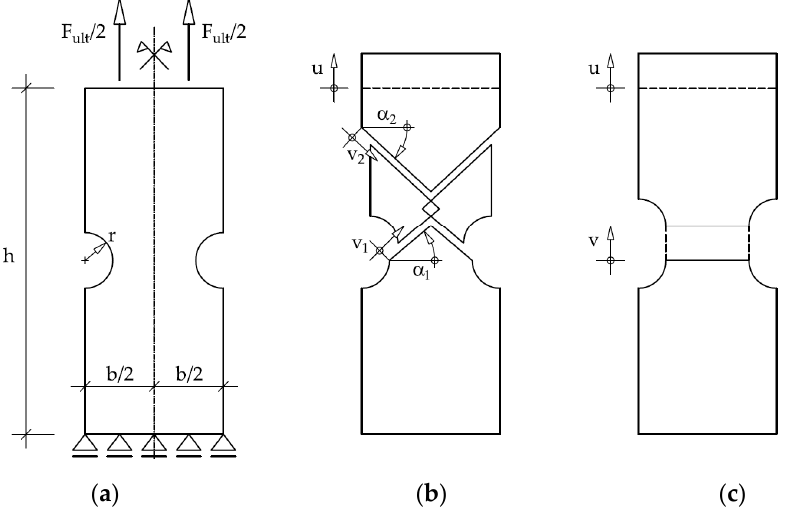
Figure 8. Failure mechanisms (equivalent plastic strain) from a FEA for the tensile specimen with a hole: ( a ) Mesh; ( b ) yield surface according to the T resca criterion was used; ( c ) yield surface according to the M ises criterion was used.